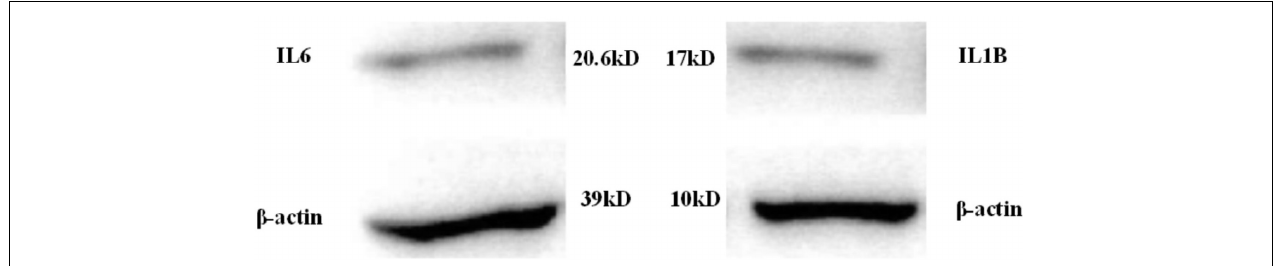
FIGURE 10 | Protein expressions of IL6 and IL1B in patients with lung